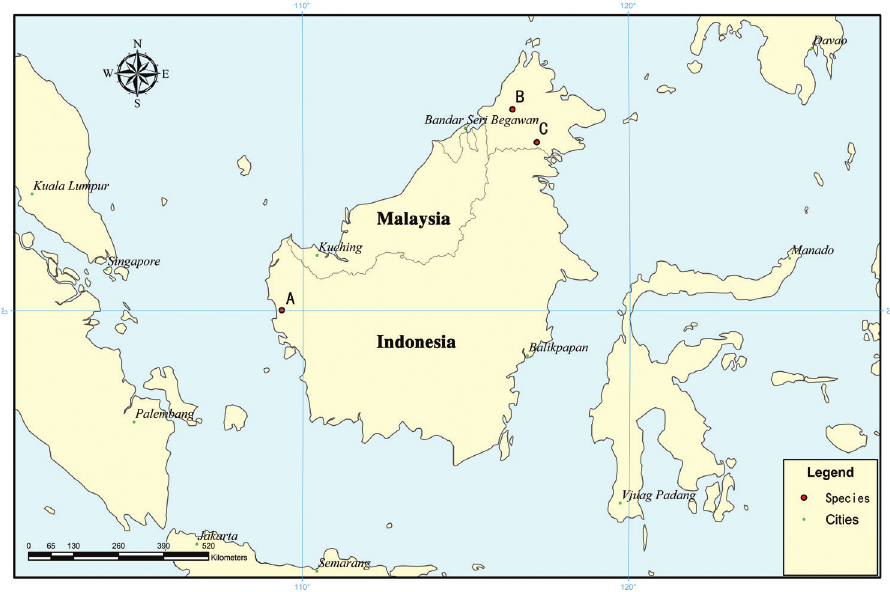
Figure 36. Distribution of Lobonychium palpiplus Roewer, 1938 in Borneo. A type locality B Trus Madi Mountain C